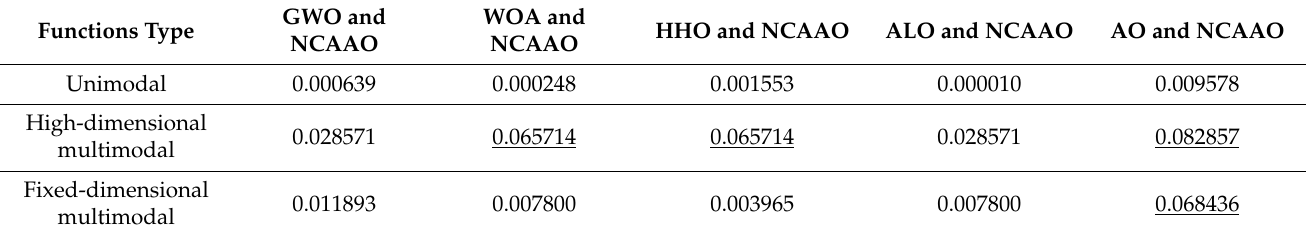
Table 8. The p -values obtained from Wilcoxon sum rank test. ( p ≥ 0.05 have been